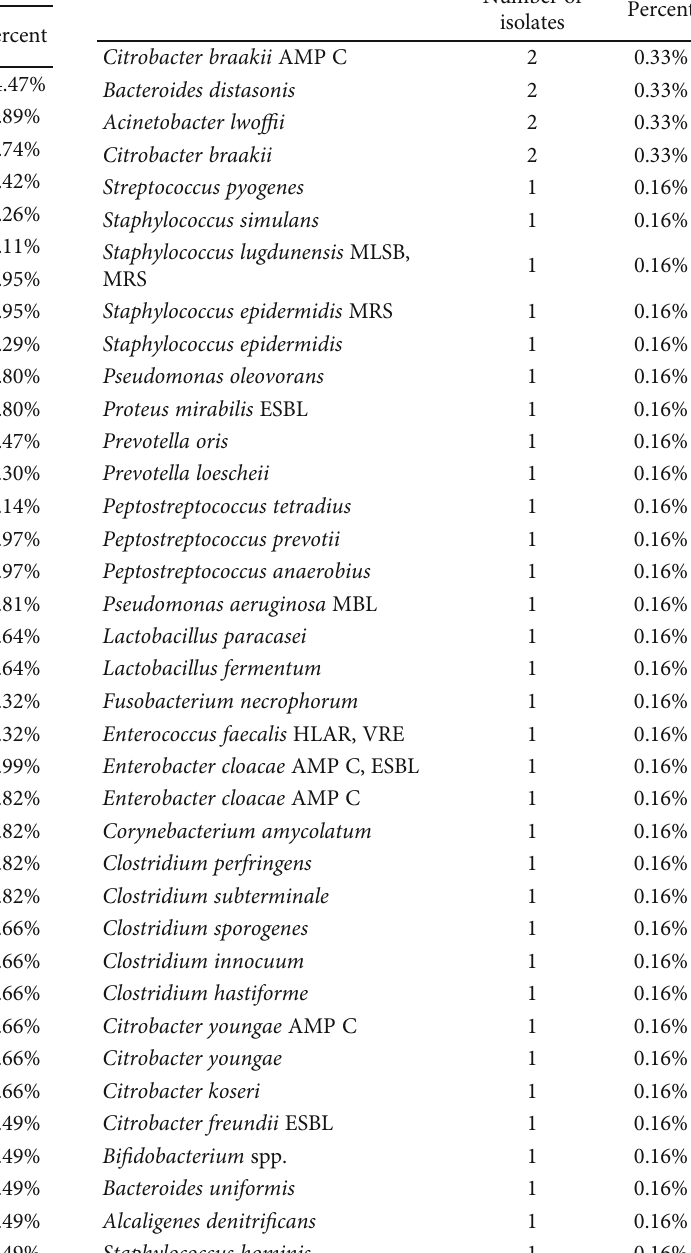
Table 2: Number of particular bacterial isolates in all patients with nonischemic diabetic foot syndrome.